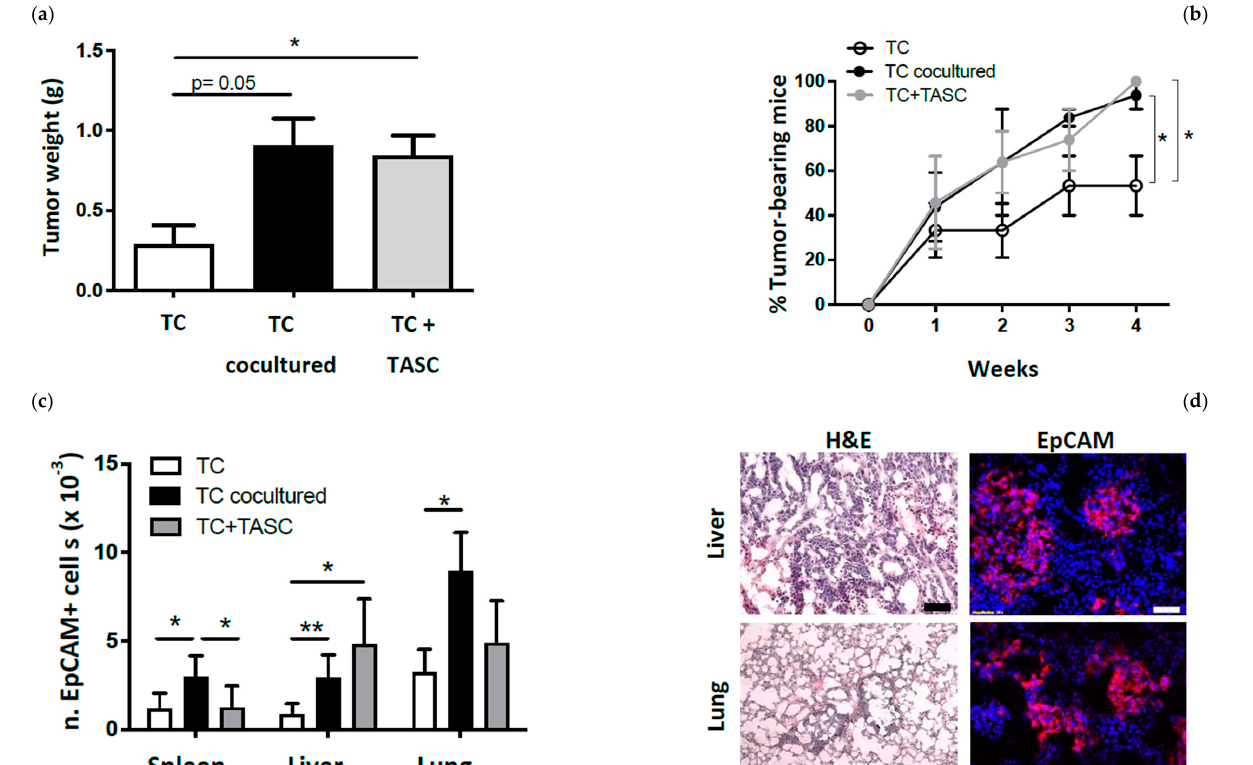
Figure 4. TASCs support growth and metastatic spread of orthotopic tumor xenografts. ( a ) Tumor incidence in NSG mice injected i.c. with GFP/Luc-LS180 alone (TC), cocultured with TASCs and sorted prior to injection (TC cocultured), or cultured alone and admixed with TASCs prior to injection (TC+TASC). Data (means ± SD) refer to two experiments performed with TASCs isolated from two different colon cancer samples ( n = 9/experimental group). ( b ) Tumor weights as measured four weeks after injection. Data (means ± SD) refer to two experiments performed with TASCs isolated from two different colon cancer samples ( n = 9/experimental group). Statistical significance was evaluated by Mann–Whitney test (* p ≤ 0.05). ( c ) Numbers of EpCAM+ cells detected by flow cytometry in spleens, livers, and lungs of NSG mice injected as detailed above ( n = 9/group; Mann–Whitney test, * p ≤ 0.05, ** p ≤ 0.01). ( d ) Representative histological analysis by hematoxylin and eosin (H&E) and immunofluorescence staining of EpCAM (red) of metastatic foci in livers and lungs. Magnification 20 × , scale bar 100 µ